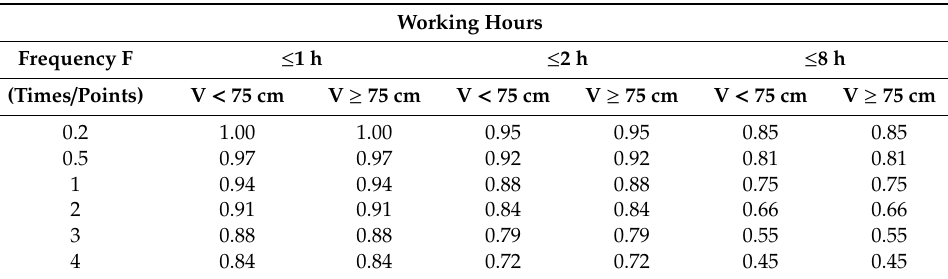
Table 2. FM frequency